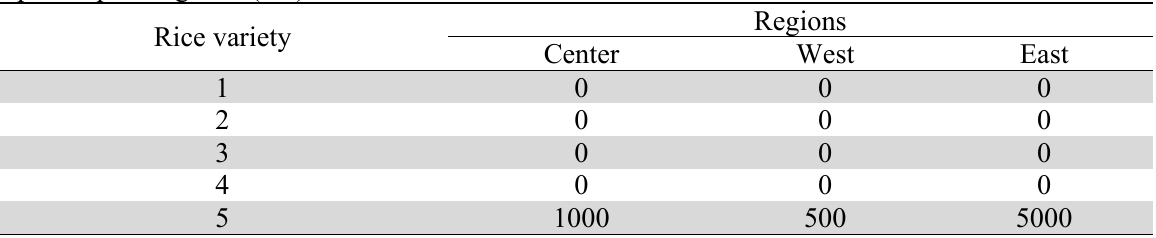
Optimal planting area (ha 2 )